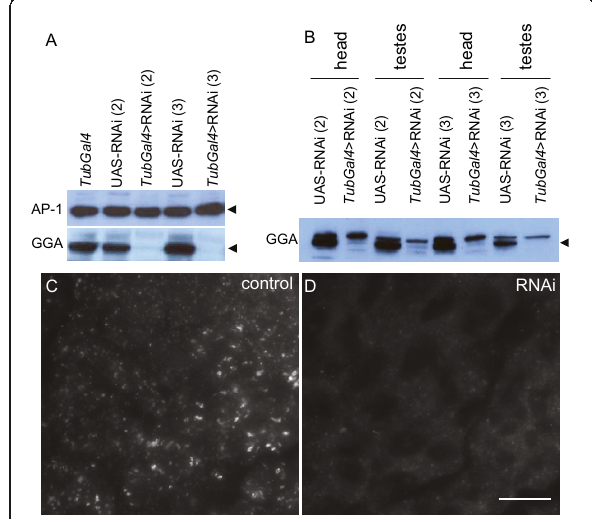
Figure 6 GGA depletion in transgenic RNAi fly lines . (A) GGA was depleted ubiquitously in 2 fly lines [insertions on chromosome (2) or chromosome (3)] using a Tubulin-Gal4 driver, and whole fly homogenates Western blotted for GGA and AP-1. In both fly lines depletion of GGA was achieved to >95%. Note that AP-1 expression does not alter in the GGA knockdown flies. (B) GGA knockdown flies were dissected into head and testes and the efficiency of knockdown determined by Western blotting. Note that the GGA antibody recognises a doublet, but only the bottom band is knocked down (arrowhead). Quantitation of the gels bands demonstrates that the knockdown efficiency in testes is >95%, similar to that seen in head extracts. Testes squashes from control (C) and GGA knockdown flies (D) were labelled with antibodies against GGA. Note that GGA labelling is almost completely lost in knockdown fly testes suggesting efficient GGA depletion. Bar, 20 μ